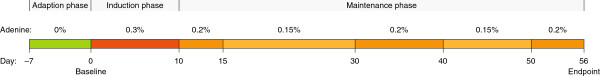
Schematic view of the 8-week proof-of-concept study of adenine-induced renal failure in mice. The study was preceded by a 7-day adaptation phase, and comprised a 10-day induction phase (day 0–9) and a maintenance phase (day 10–56).